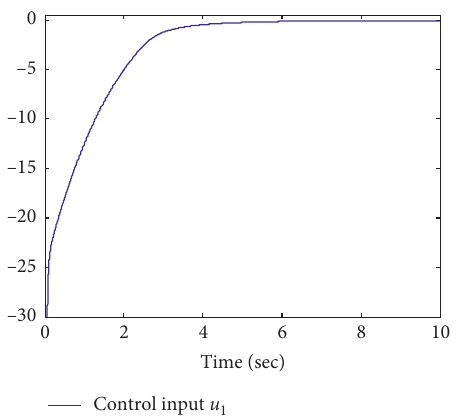
Figure 7: Control input u